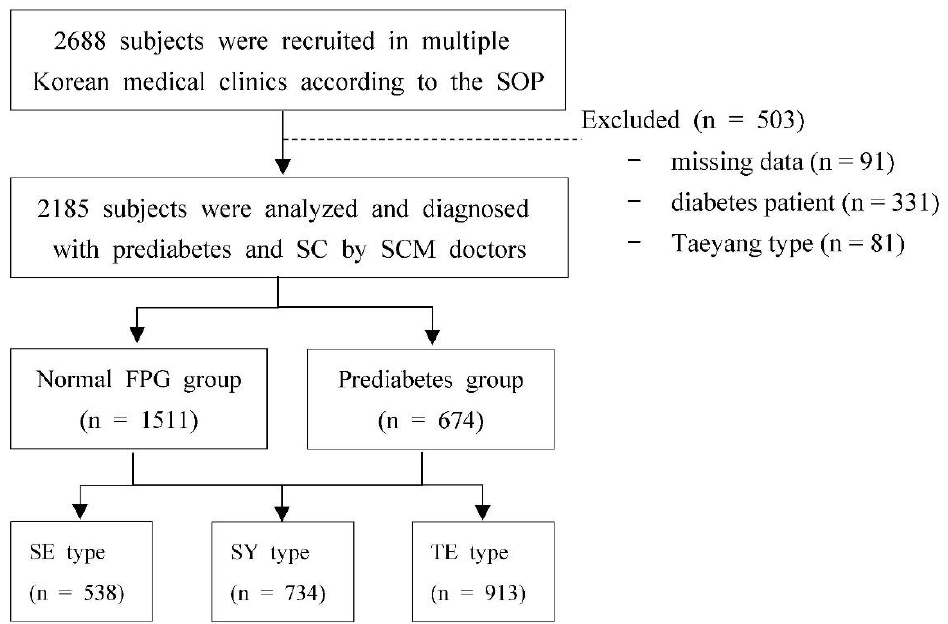
Figure 1. Flowchart of the study. SOP: Standard operating procedure, SC: Sasang constitution, SCM: Sasang constitutional medicine, FPG: fasting plasma glucose, SE: Soeumin, SY: Soyangin, TE: Taeeumin.